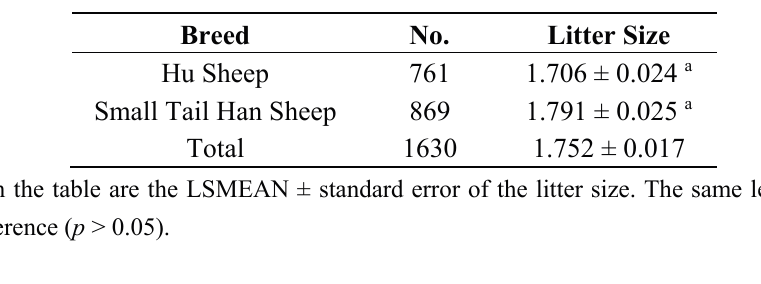
Table 5. Experimental population structure and litter size phenotypic